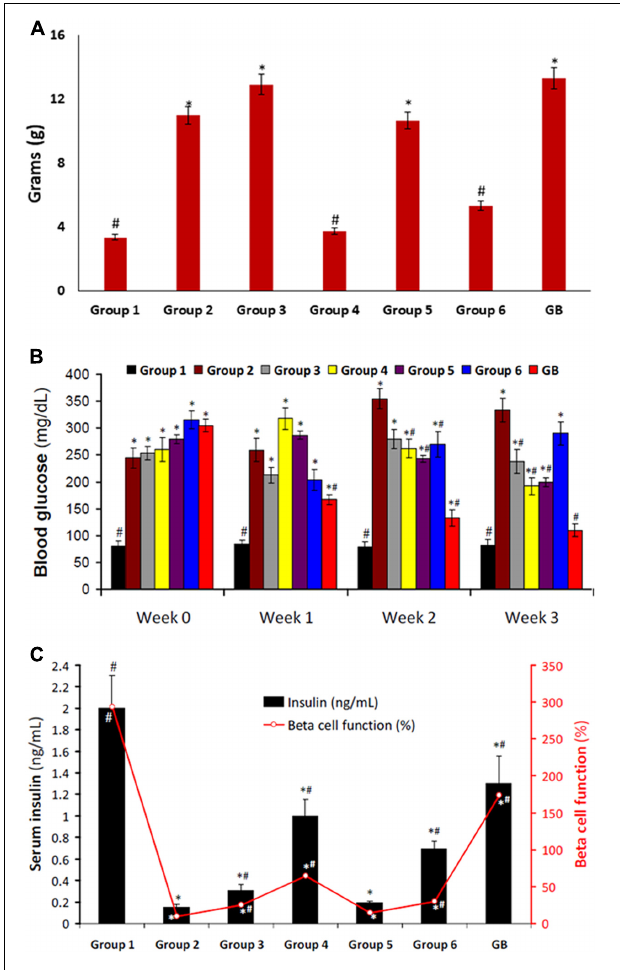
FIGURE 2 | (A) Body weight gain of experimental groups. Data = mean ± SD ; n = 6. # Statistically significant ( p < 0.05) compared to group 2; ∗ statistically significant ( p < 0.05) compared to group 1. Group 1: normal control; Group 2: diabetic control; Group 3: diabetic rats + crude extract; Group 4: diabetic rats + dichloromethane fraction; Group 5: diabetic rats + butanol fraction; Group 6: diabetic rats + aqueous fraction; GB: diabetic rats + glibenclamide. (B) Blood glucose level of experimental groups. Data = mean ± SD ; n = 6. # Statistically significant ( p < 0.05) compared to group 2; ∗ statistically significant ( p < 0.05) compared to group 1. Group 1: normal control; Group 2: diabetic control; Group 3: diabetic rats + crude extract; Group 4: diabetic rats + dichloromethane fraction; Group 5: diabetic rats + butanol fraction; Group 6: diabetic rats + aqueous fraction; GB: diabetic rats + glibenclamide. (C) Serum Insulin level and β -cell function of experimental groups. Data = mean ± SD ; n = 6. # Statistically significant ( p < 0.05) compared to group 2; ∗ statistically significant ( p < 0.05) compared to group 1. Group 1: normal control; Group 2: diabetic control; Group 3: diabetic rats + crude extract; Group 4: diabetic rats + dichloromethane fraction; Group 5: diabetic rats + butanol fraction; Group 6: diabetic rats + aqueous fraction; GB: diabetic rats + glibenclamide.